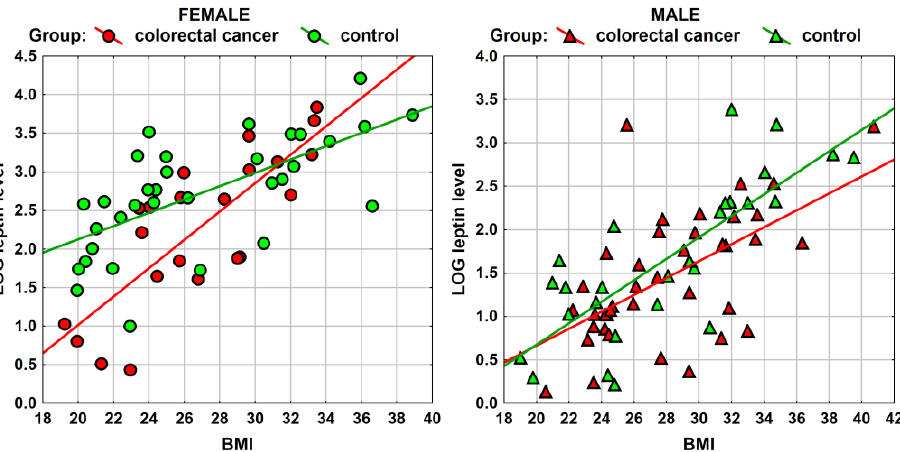
Figure 6. Relationship between BMI and leptin concentration in logarithmic form in the study and comparative group separately for females and males. Study group: female ( n = 22); male ( n = 39). Control group: female ( n = 33); male ( n = 27).